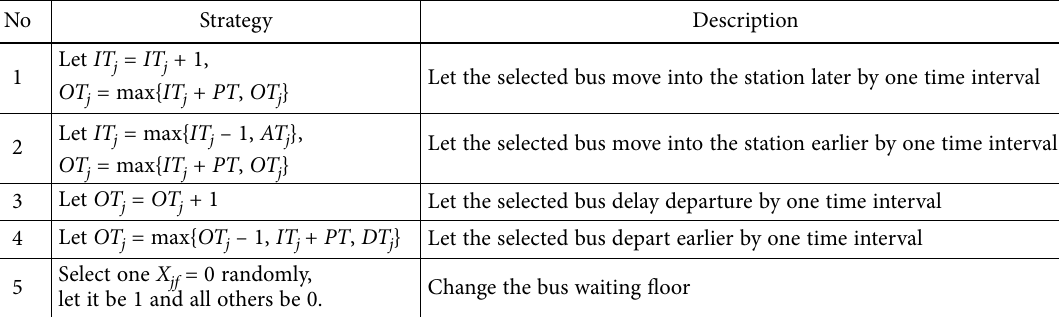
Table 2. Strategies for generating new